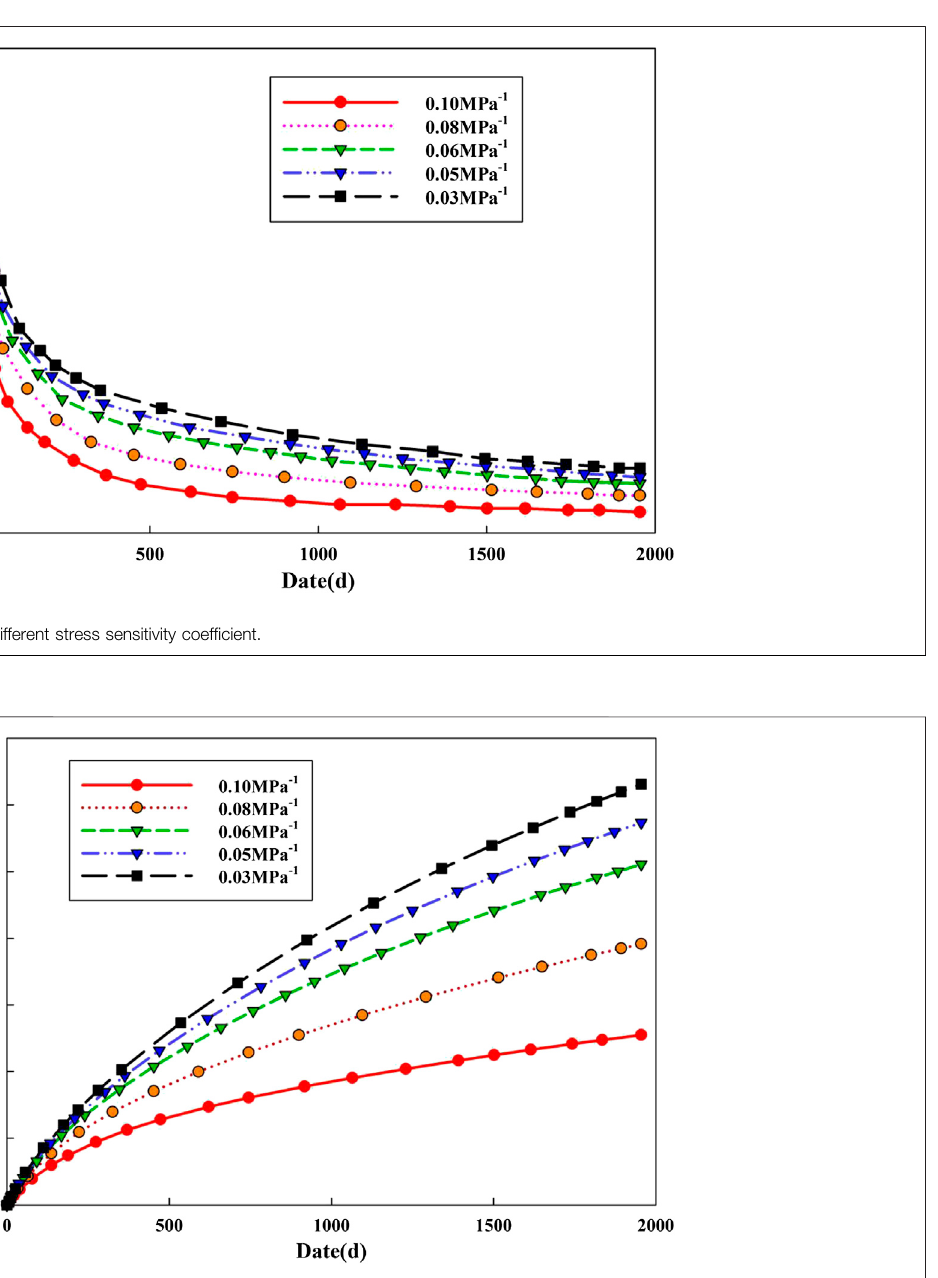
FIGURE 8 | Cumulative oil production curve of different stress sensitivity coef fi